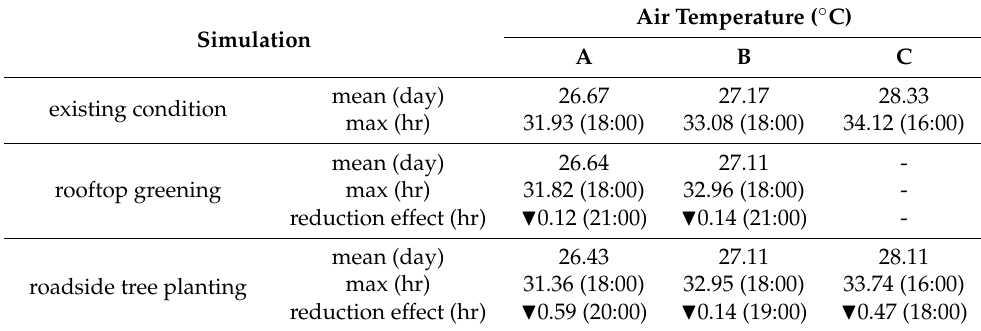
Table 5. Temperature reduction effect of rooftop greening and roadside tree planting.